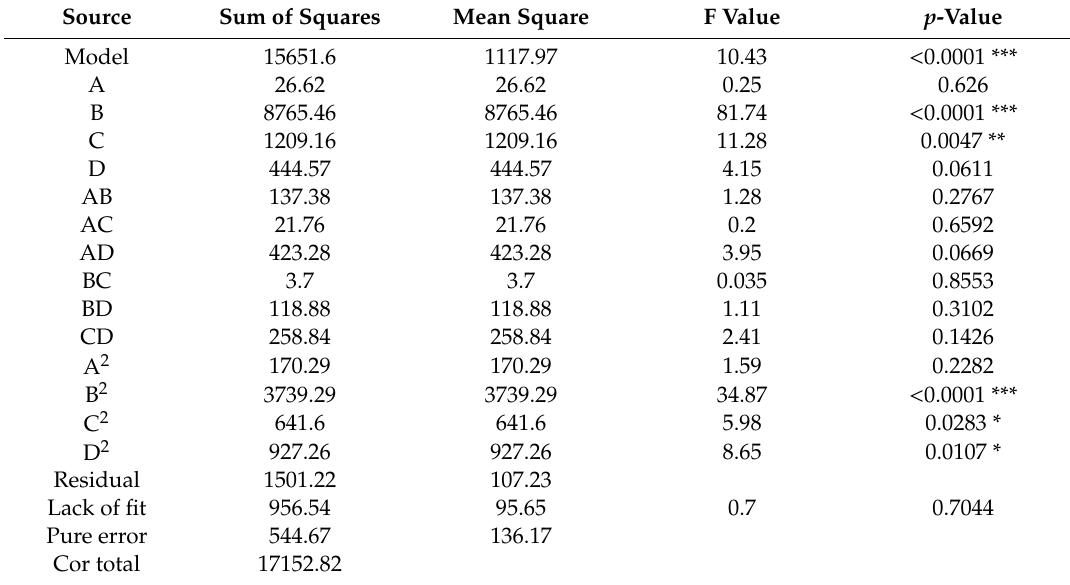
Table 2. ANOVA for response surface quadratic